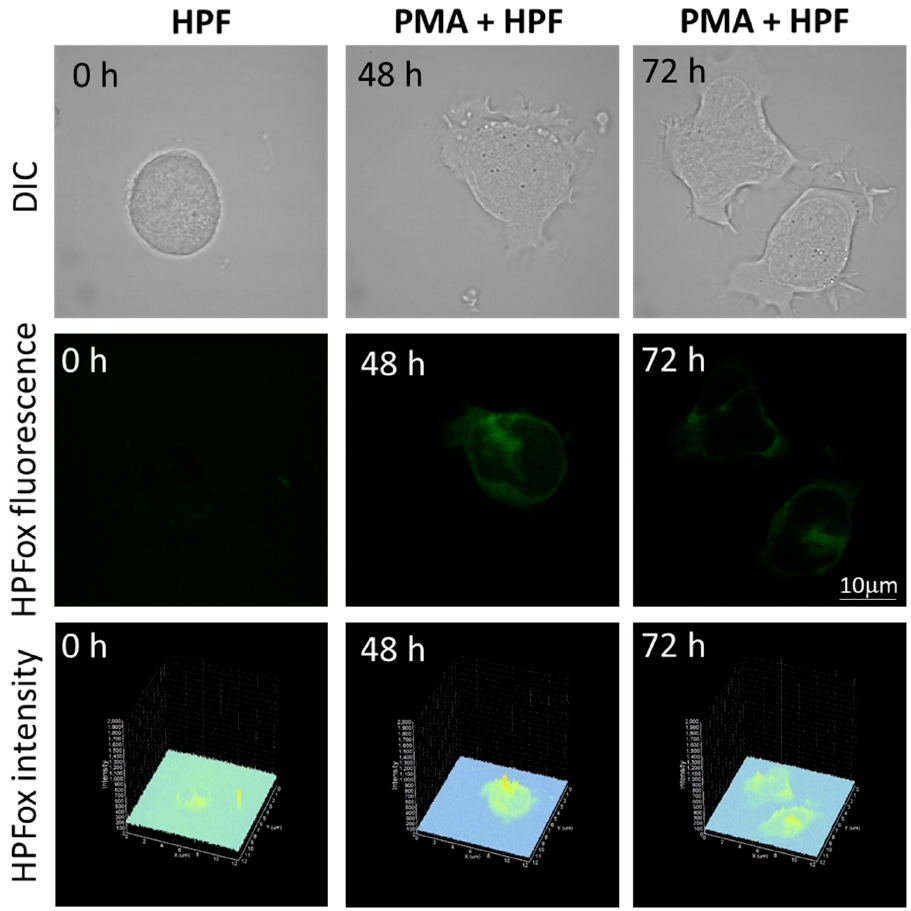
Figure 5. Hydroxyl radical imaging. U937 cells were incubated with 1 µM HPF for 12 h in the absence ( left panel ) and presence of 250 nM PMA for 48 h ( middle panel ) or for 72 h ( right panel ). Images from DIC channel and HPF-ox fluorescence (green signal) are presented. The lower panel shows the integral distribution of the signal intensity within the sample ( Z -axis represents the levels of brightness for each pixel, ranging between 0 and